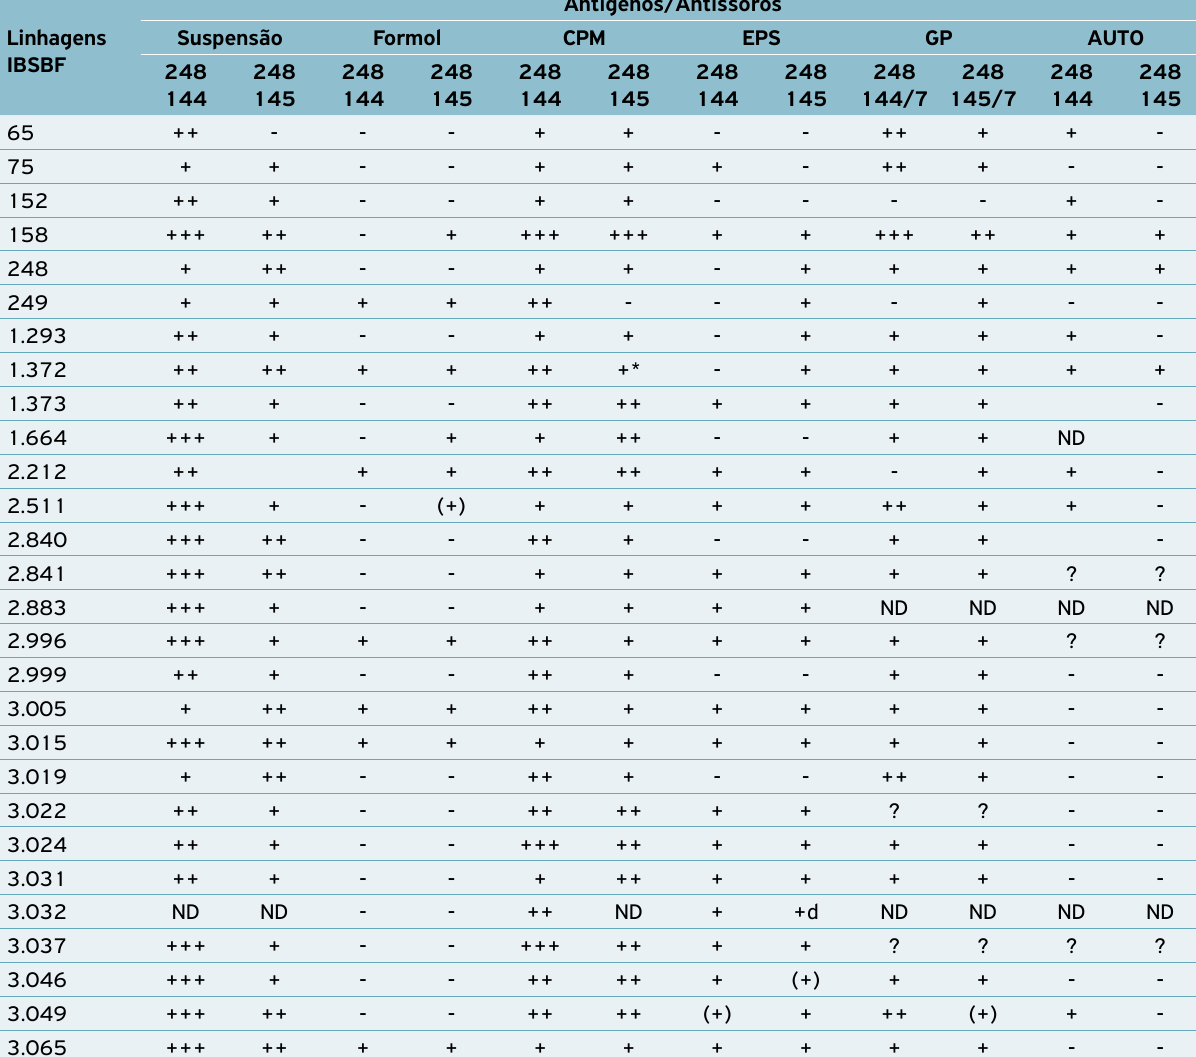
Tabela 3. Testes serológicos entre os antissoros produzidos contra células totais (As-248-114) e contra proteínas de membrana (As-248-115) de P. s . pv. garcae